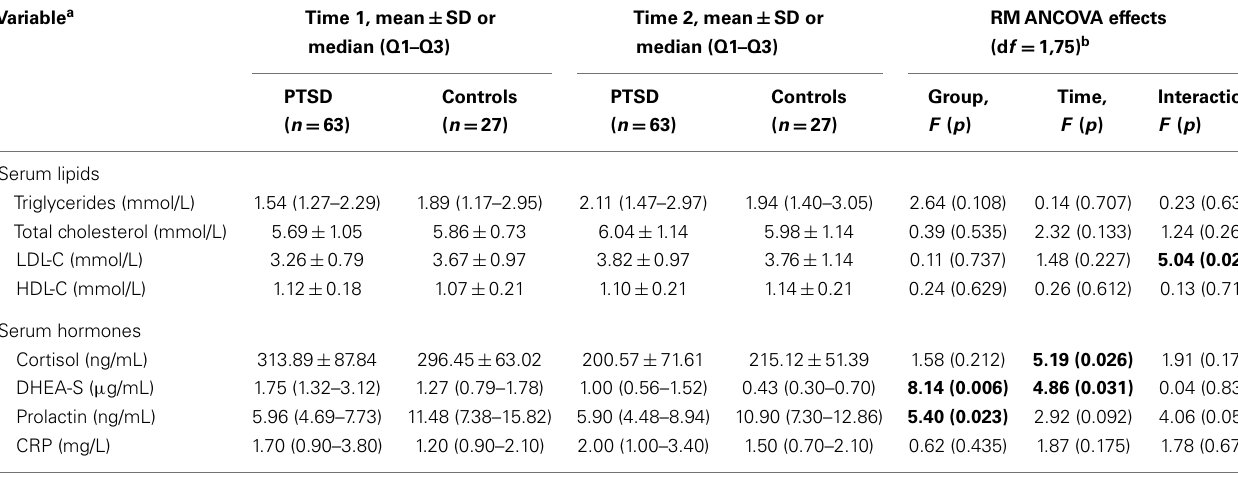
Table 2 | Serum lipids, hormones, and C-reactive protein (CRP) analyzed by repeated measures analysis of covariance (RMANCOVA) . Variable a